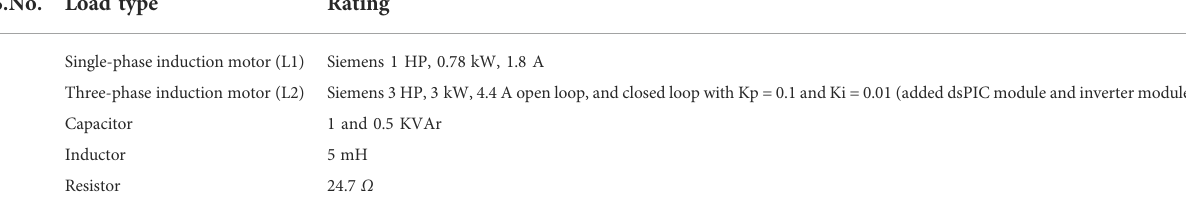
TABLE 8 Rating of different loads and parameter values of the fi